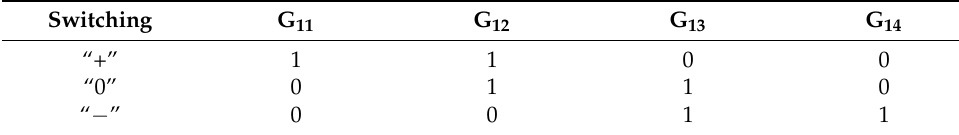
Table 2. D-NPC (diode neutral-point-clamped) switching table.